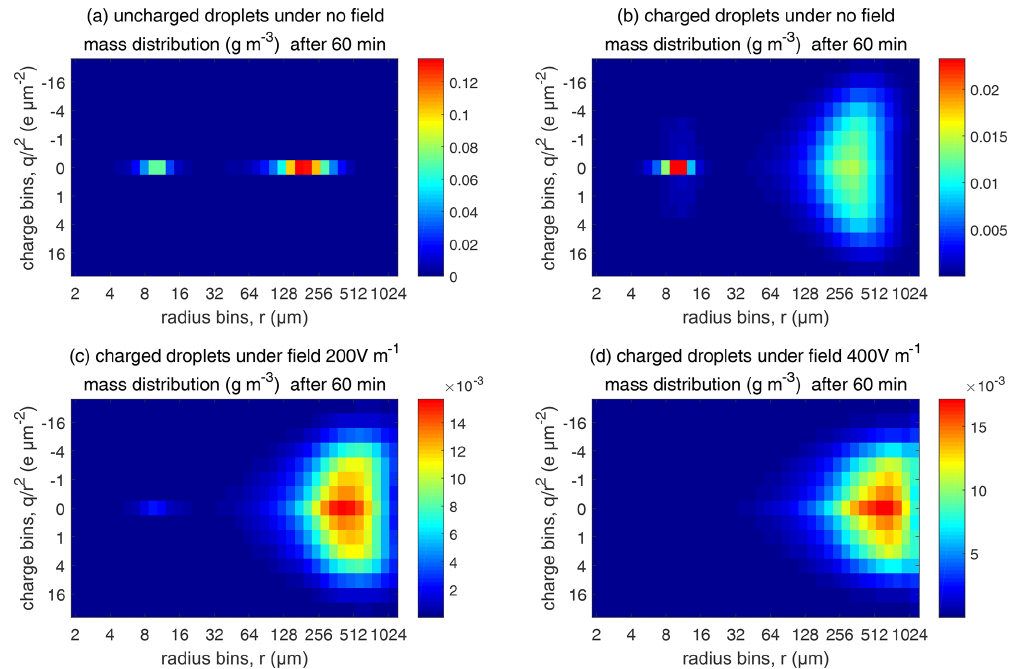
Figure 13. Comparison of evolutions of the 2D distribution of droplet mass concentration with different electric conditions at 60min (initial ¯ r = 9µm).